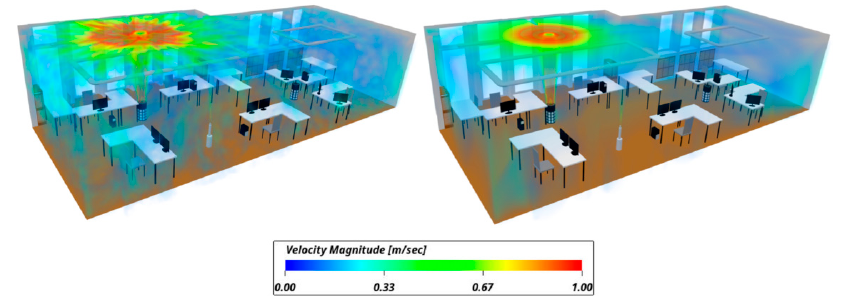
Figure 11. Flow distribution differences between VLES ( left ) and equivalent uRANS ( right ).